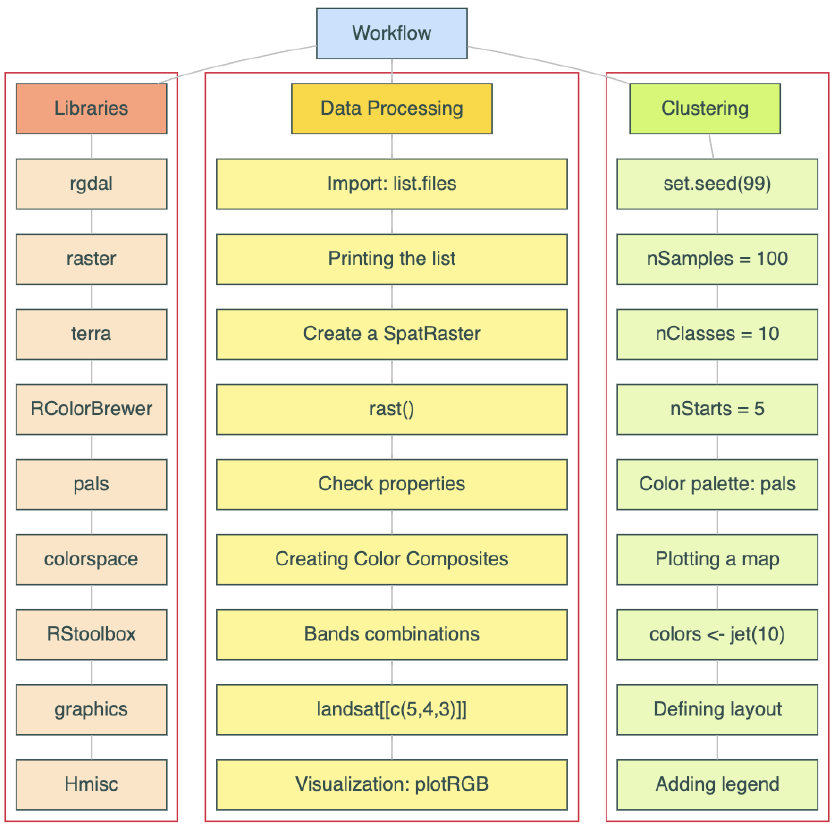
Figure 6. Methodological workflow of the processes and research steps applied in this study. Software: R version 4.2.2, ’DiagrammeR’ library. Flowchart source: